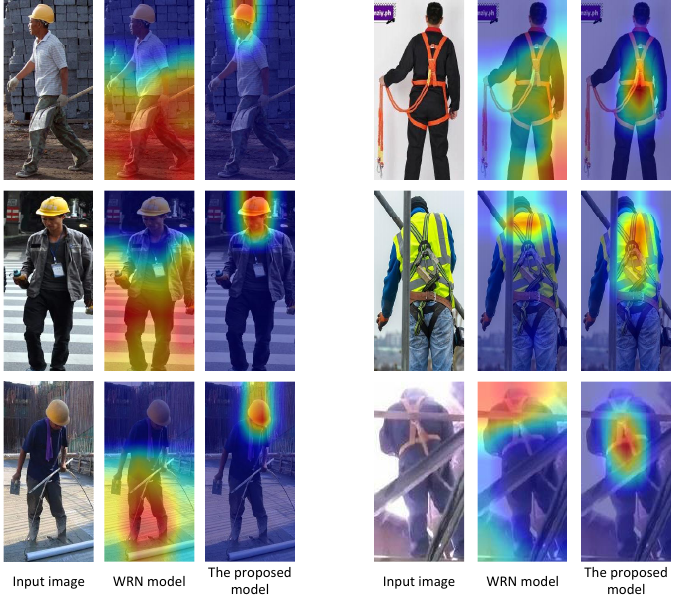
Figure 9. Attention regions of different models and attributes. The left is the visual feature map for the safety helmet attribute, and the right is the visual feature map for the safety harness attribute.